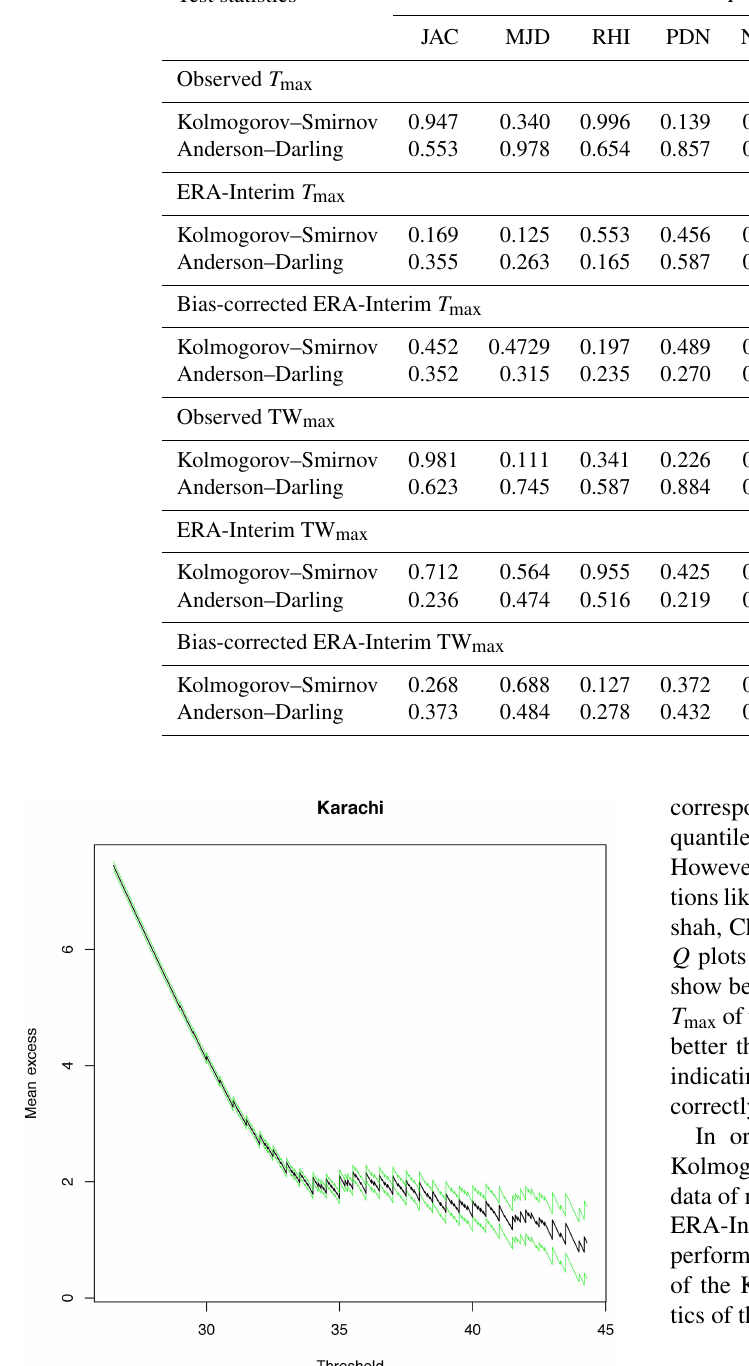
Table 3. The spatial distribution of the shape parameter ξ and the scale parameter σ of the GPD in Sindh is shown in Fig.